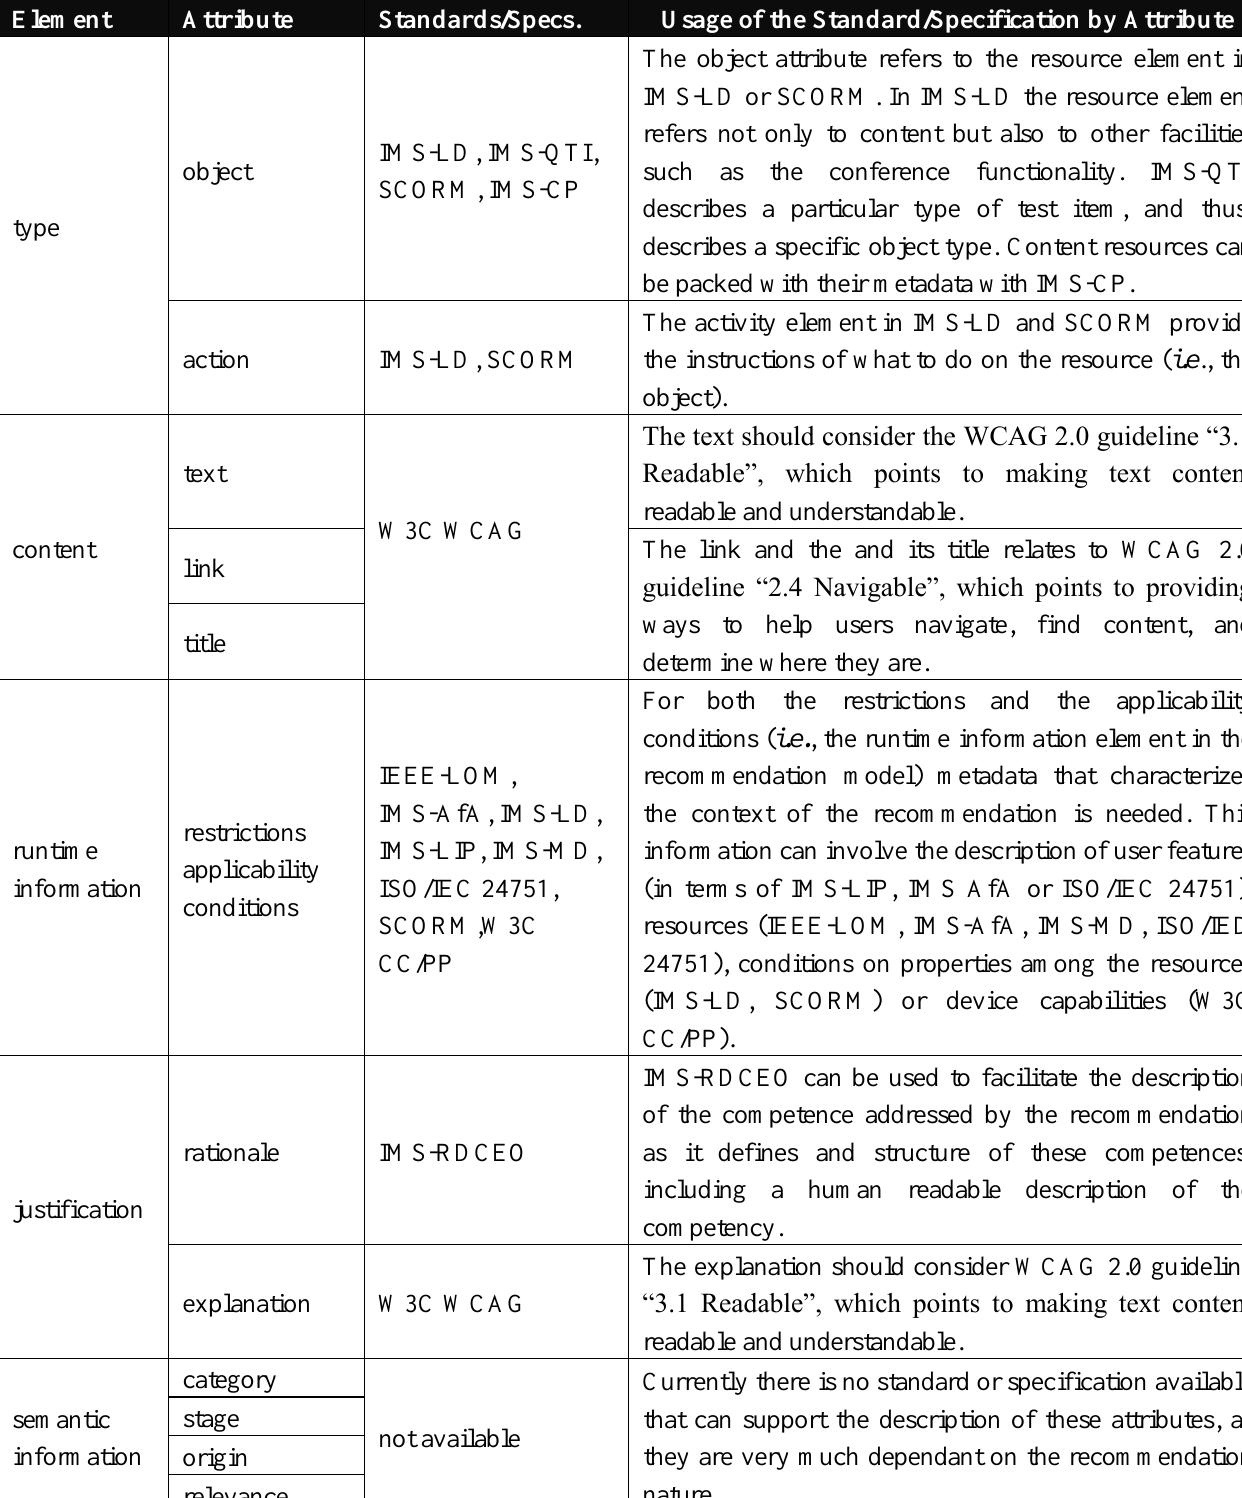
Table 4. Standards and specification that can be considered by the recommendation model